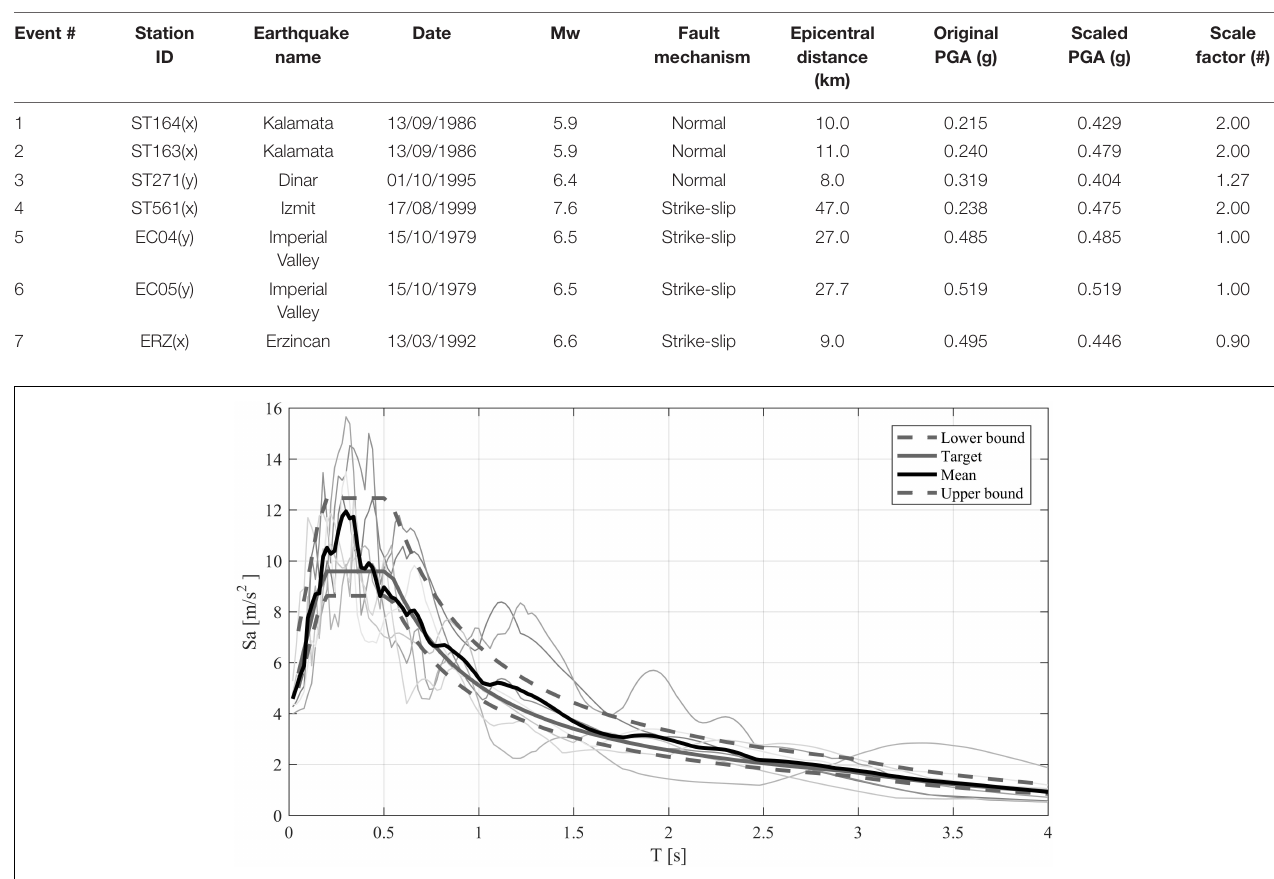
TABLE 1 | Selection of natural events.